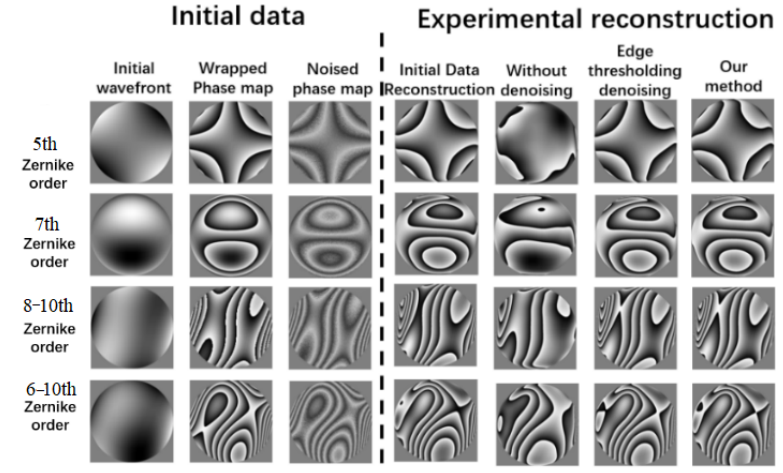
Figure 13. The images captured by SH sensor with different Zernike orders where ( a 1 , b 1 , c 1 , d 1 ) de- note the images without noise, respectively; ( a 2 , b 2 , c 2 , d 2 ) denote the images with noise, respectively.